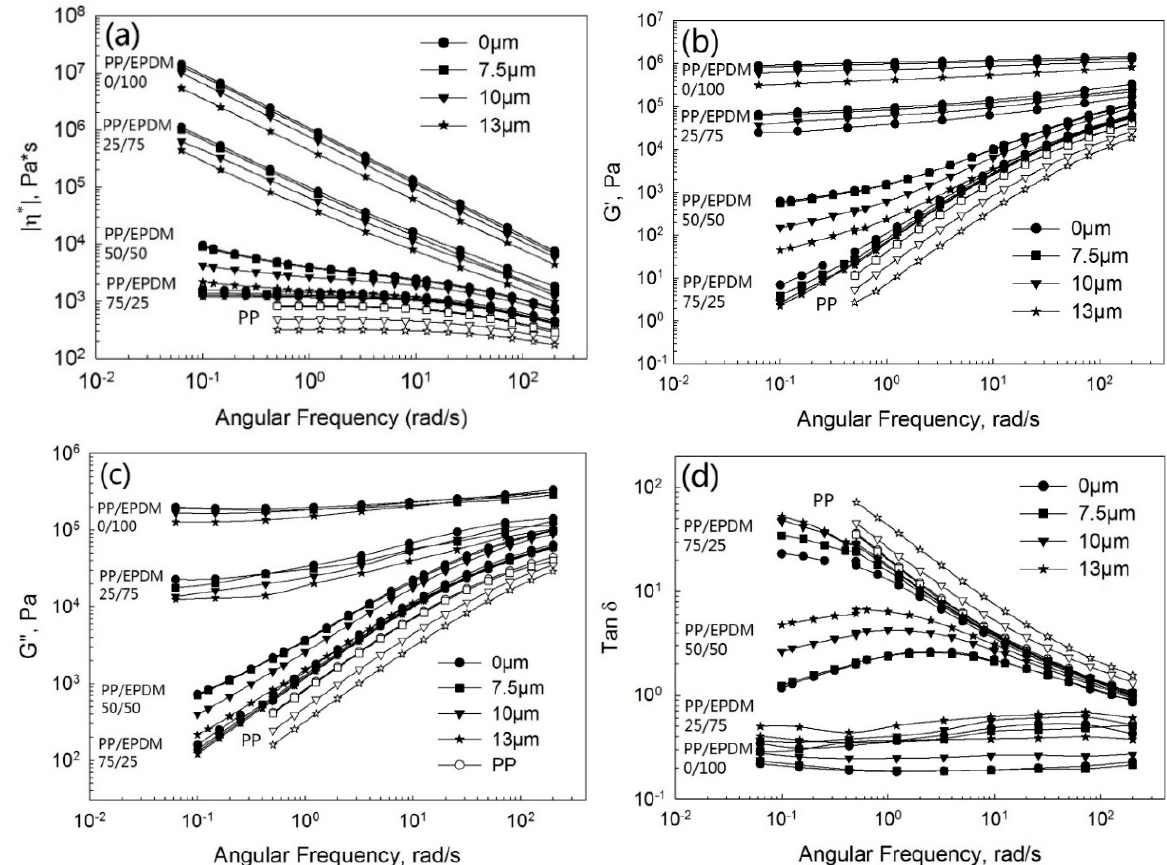
Figure 5. Complex viscosity ( a ), storage moduli ( b ), loss moduli ( c ), and loss tangent ( d ) as a function of the frequency for the pure PP, devulcanized EPDM, and PP/EPDM blends prepared by the TS method.